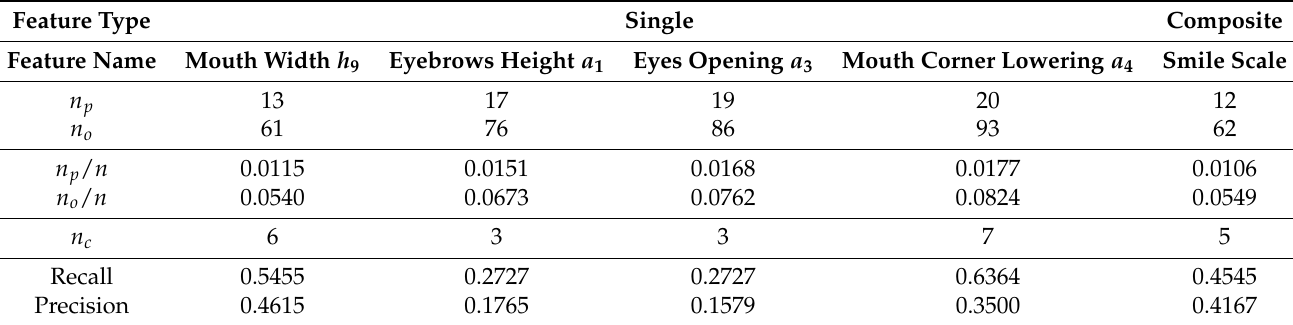
Table 4. Various parameters and ratios measured (Subject A: number of whole data n = 1129, number of event points n e = 11).